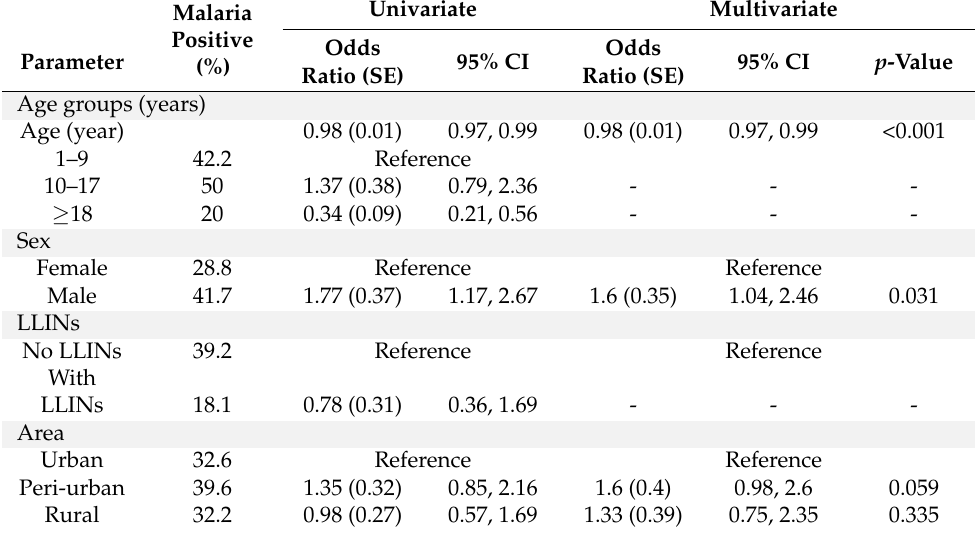
Table 2. Final logistic regression